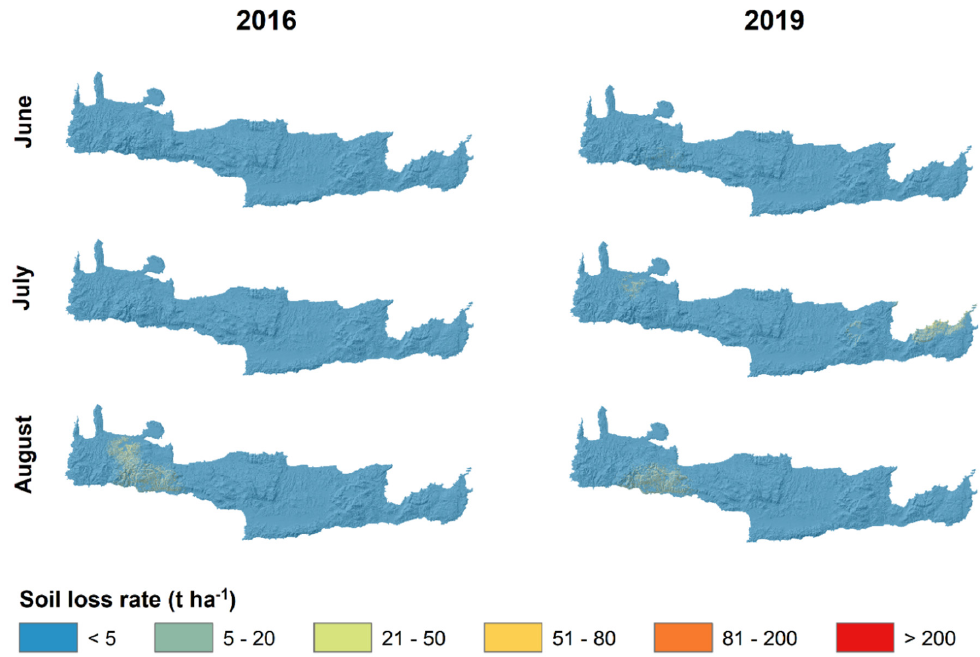
Figure 5. Monthly spatial distribution of soil loss rate for Crete Island in 2016 and 2019.